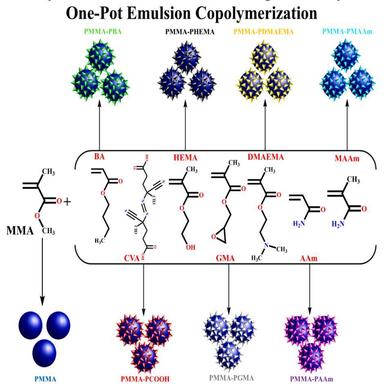
Schematic illustration for the synthesis of multi-functionalized copolymer nanoparticles by one-pot emulsion polymerization.